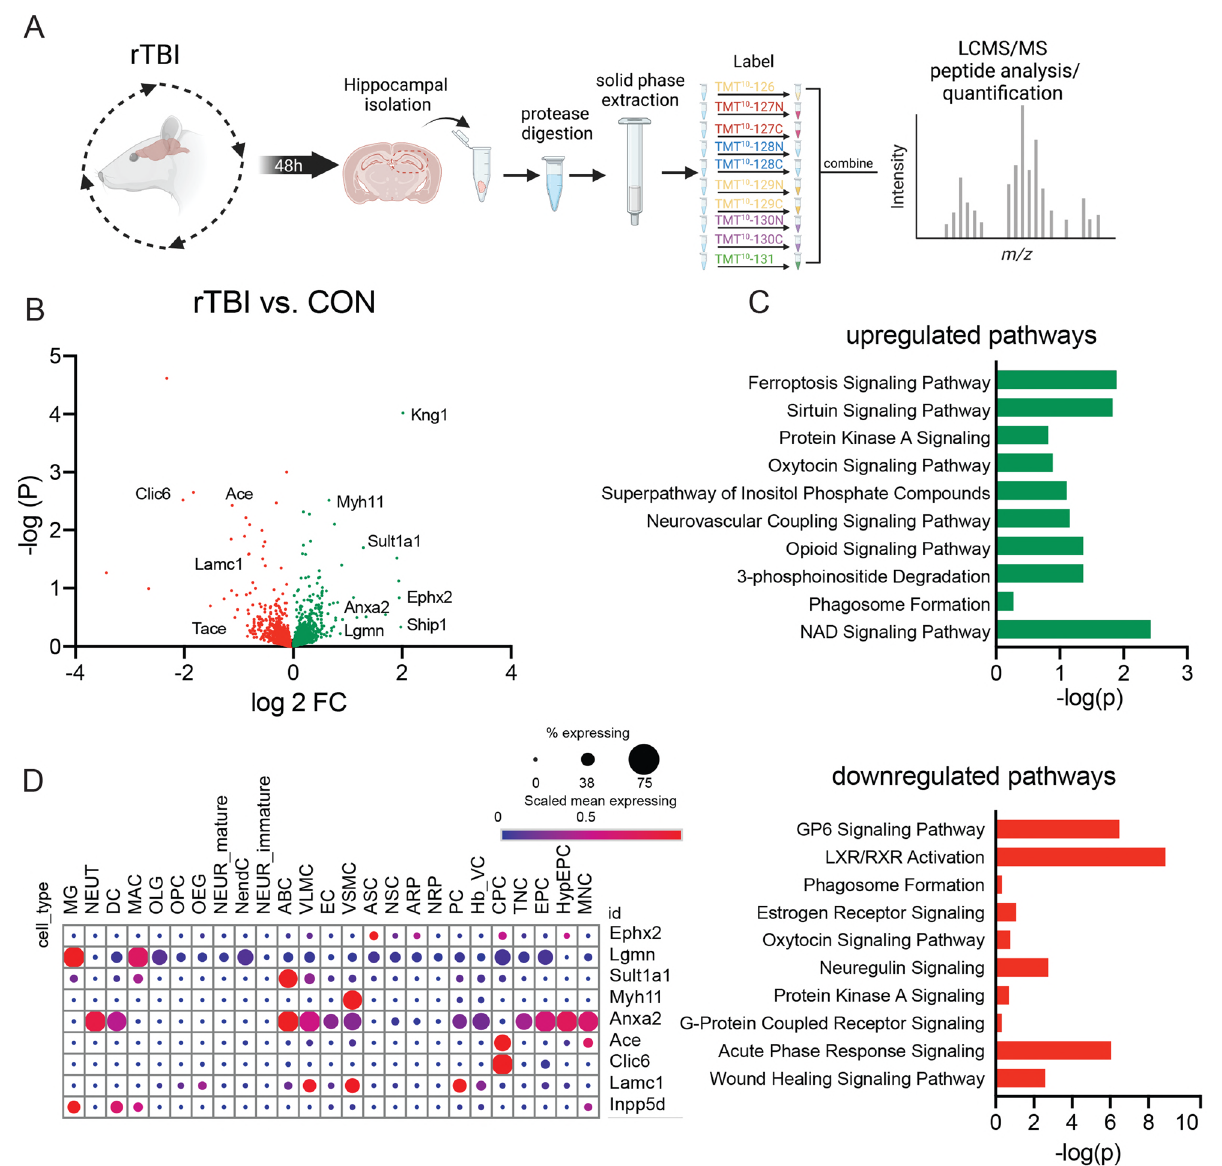
Figure 4. Proteomic alterations following rTBI. ( A ) Experimental design schematic for tissue isolation, extraction, labeling, and peptide detection for discovery proteomics. ( B ) Volcano plot of differentially expressed total proteins between rTBI and CON (control) rats (n = 5 pooled brains in duplicate per group, increased sites in green decreased sites in red). ( C ) (Top) Ingenuity Pathway Analysis of upregulated proteins following rTBI. (Bottom) Ingenuity Pathway Analysis of downregulated proteins following rTBI. ( D ) Cell-type expression profile in brain of differentially expressed proteins assessed from available dataset 47 . Abbreviations: (ABC) Arachnoid barrier cells, (mNEUR) Mature neurons, (ARP) Astrocyte-restricted precursors, (NendC) Neuroendocrine cells, (ASC) Astrocytes, (NEUT) Neutrophils, (CPC) Choroid plexus epithelial cells, (NRP) Neuronal-restricted precursors, (DC) Dendritic cells, (NSC) Neural stem cells, (EC) Endothelial cells, (OEG) Olfactory ensheathing glia (EPC) Ependymocytes, (OLG) Oligodendrocytes, (Hb_VC) Hemoglobin-expressing vascular cells, (OPC)Oligodendrocyte precursor cells, (HypEPC) Hypendymal cells, (PC) Pericytes (ImmN) Immature neurons, (TNC) Tanycytes, (MAC) Macrophages, (VLMC) Vascular and leptomeningeal cells, (MG) Microglia, (VSMC) Vascular smooth muscle cells, (MNC)